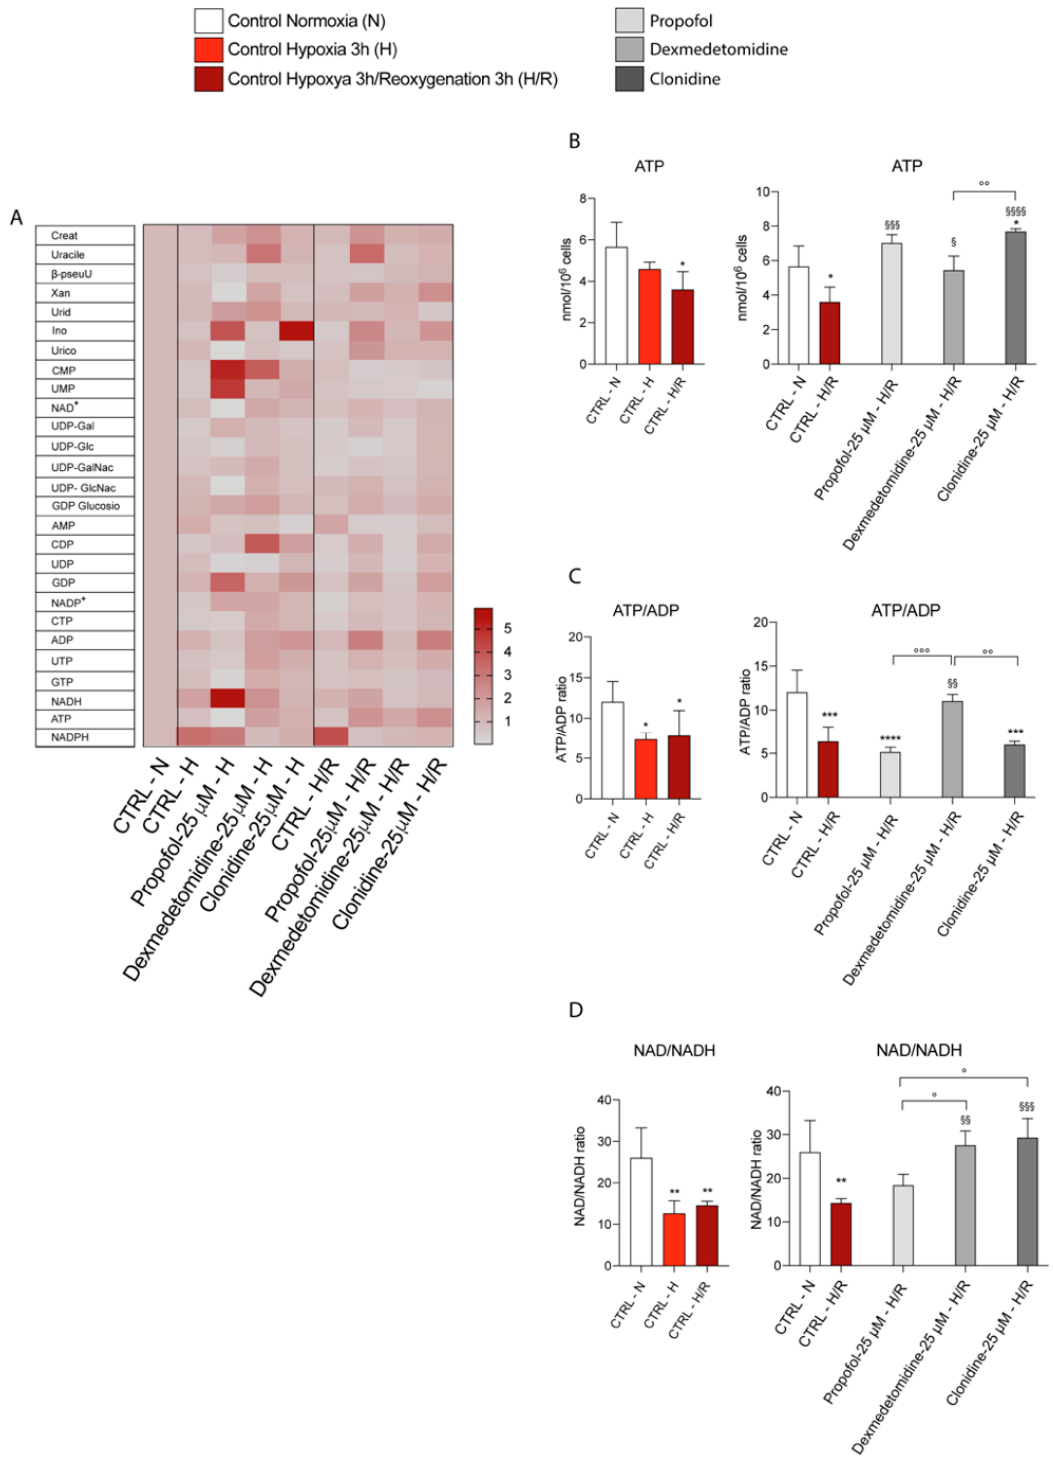
Figure 7. ( A ) Heatmap representing the levels of major classes of metabolites detected by HPLC. ( B ) ATP levels; ( C ) ATP/ADP levels; ( D ) NAD/NADH levels. Results are presented as the mean ± SD of four independent experiments.. * vs. CTRL Normoxia (* p < 0.01; *** p < 0.001); § vs. CTRL Hypoxya/reoxygenation ( §§ p < 0.005; §§§ p < 0.001); ° vs. the different drugs (propofol vs. dexmedetomidine; propofol vs. clonidine; dexmedetomidine vs. clonidine) (° p < 0.05; °° p < 0.005; °°° p < 0.001).